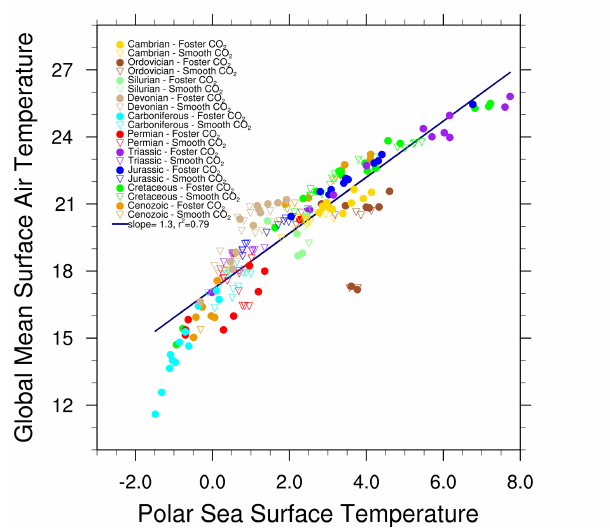
Figure 11. Correlation between the global mean, annual mean sur- face air temperature and the deep ocean temperature. The deep ocean temperatures are defined as the average temperature at the bottom of the model ocean, where the bottom must be deeper than 1000m. Other details are as in Fig.